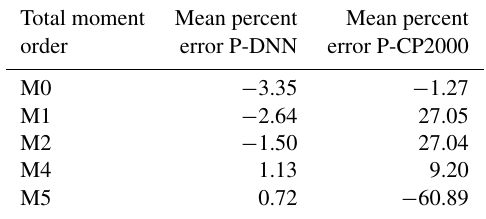
Table 5. Total moment mean errors. The percent error is taken rel- ative to the moments of KCE. The shown data were obtained by calculating the mean of the percent errors of the entire